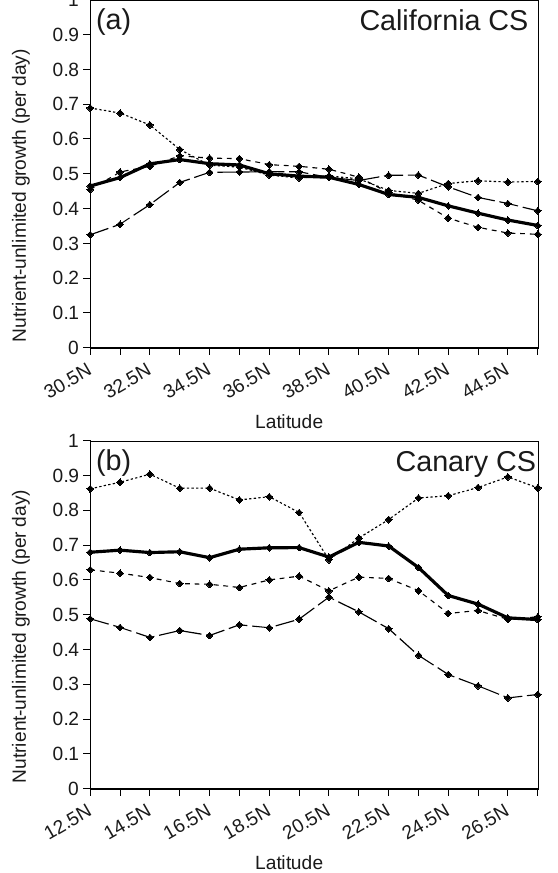
Fig. 6. Meridional distribution of the temperature-dependent, light- (T,I) limited growth rate under nutrient replete conditions µ max P in the California CS (a) and the Canary CS (b) . Data is horizon- tally averaged over the 300km wide nearshore area and vertically (T,I) (solid) over the upper 40m. Shown are the simulated µ max P (T,I) to to constant PAR = 20 Wm − 2 (long and normalized µ max P dashed), temperature T = 14 ◦ C (fine dashed) and chlorophyll-to- carbon ratio θ = 25mgC ( mgChl- a) − 1 (dotted).